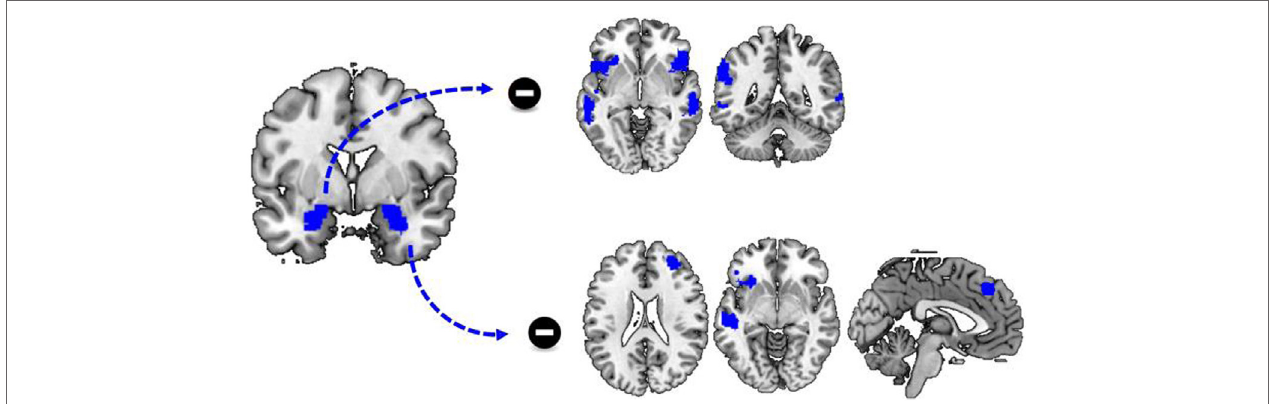
FigUre 2 | Differences in functional connectivity during cue reactivity. Functional connectivity between the left and right amygdala and a variety of brain regions is significantly reduced during the processing of cocaine cues compared to neutral cues. This includes functional connectivity between the left amygdala and the bilateral insula, inferior frontal cortex and the temporal cortex as well as functional connectivity between the right amygdala and the left insula, inferior frontal cortex and dorsomedial frontal cortex.